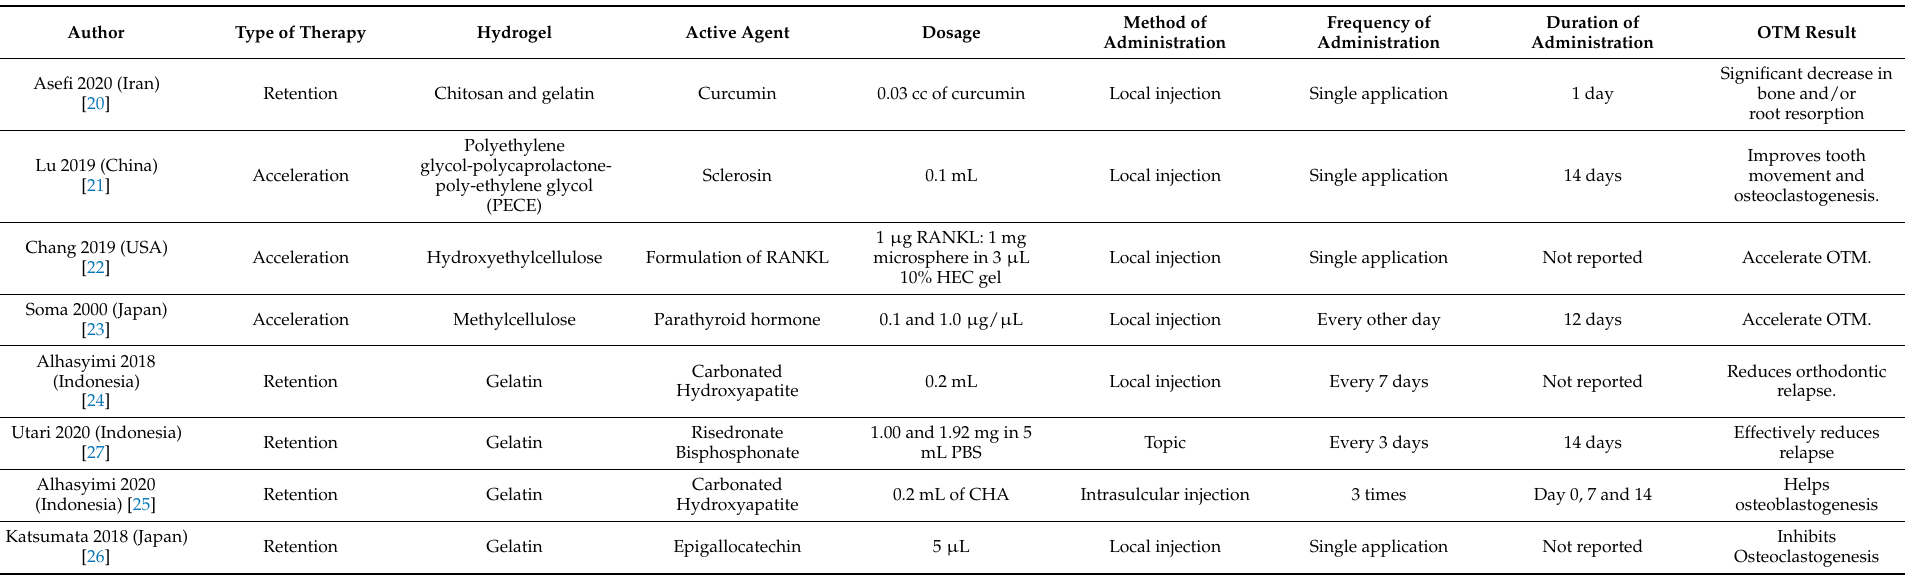
Table 3. Characteristics in relation to hydrogel